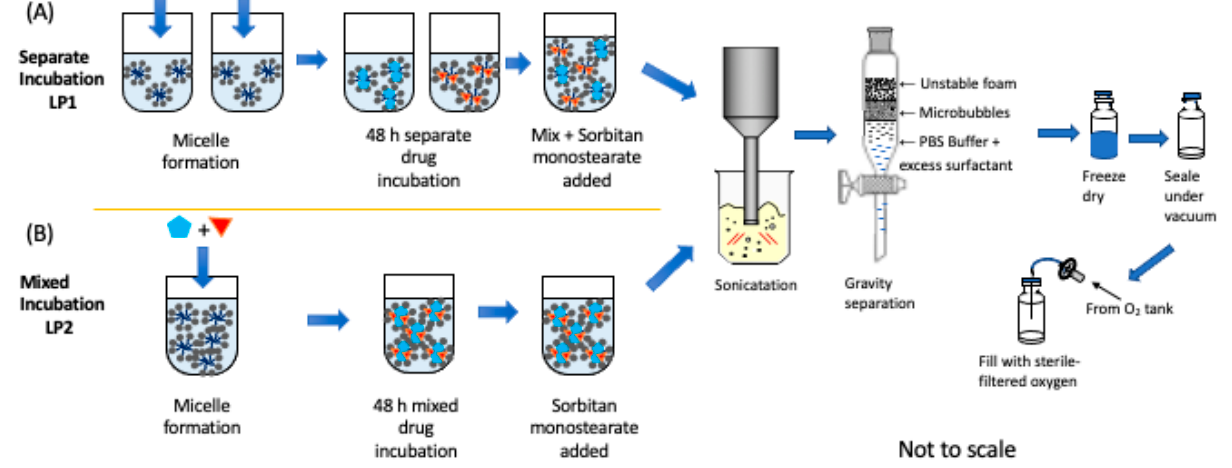
Figure 2. Process for making drug-loaded SE61 O2 . ( A ) Individual drug-loaded micelles (LP1), ( B ) Micelles containing two drugs (LP2). Turquoise pentagon represents paclitaxel, red triangle represents lonidamine, and grey represents surfactants. Not to scale.